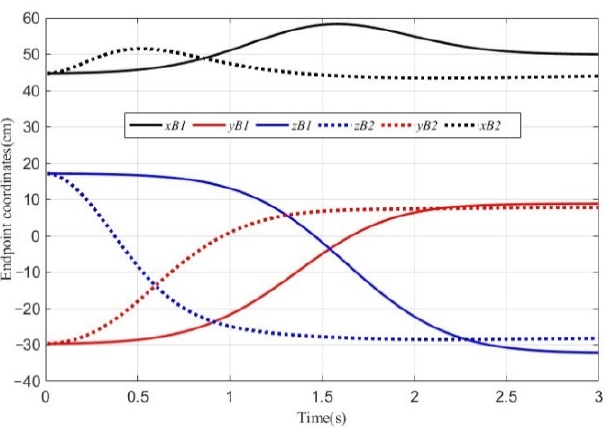
Figure 15. Comparison chart of endpoint trajectories under the controllers.